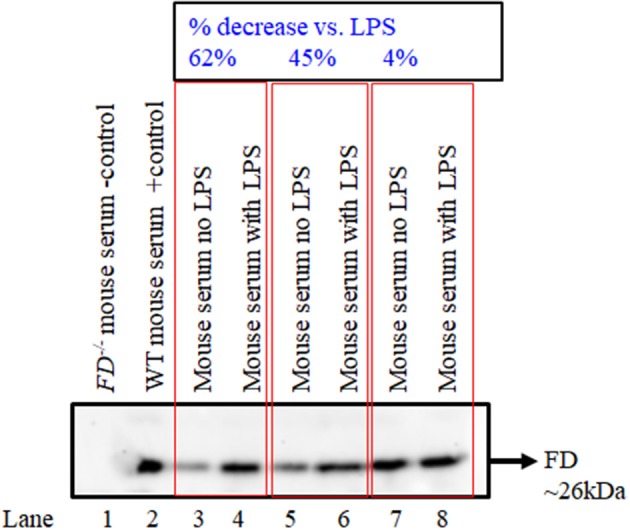
Western blot analysis for FD in serum showing the effect of simultaneously silencing of MASP-1/MASP-2 genes in WT mice followed by treatment with or without LPS. Sera from FD−/− and WT mice were used as a negative and positive controls, respectively (lanes 1 and 2). Sera from WT mice with no treatment or with treatment with LPS (lanes 3 vs. 4); (lanes 5 vs. 6) and (lanes 7 vs. 8) after MASP-1/MASP-2 silencing have been shown. The original Western blot was cut to show the actual results for FD. A band of FD ~26 kDa shows the presence of FD. Data from six mice have been shown.